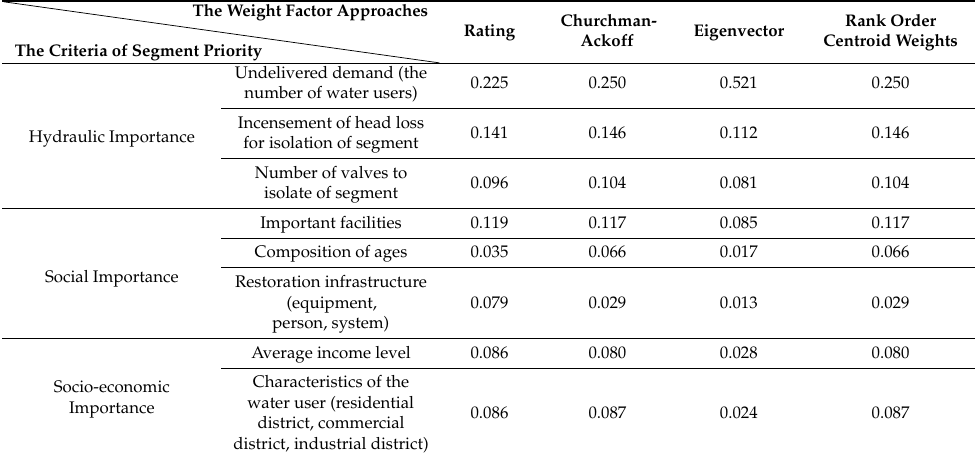
Table 5. Criteria of segment